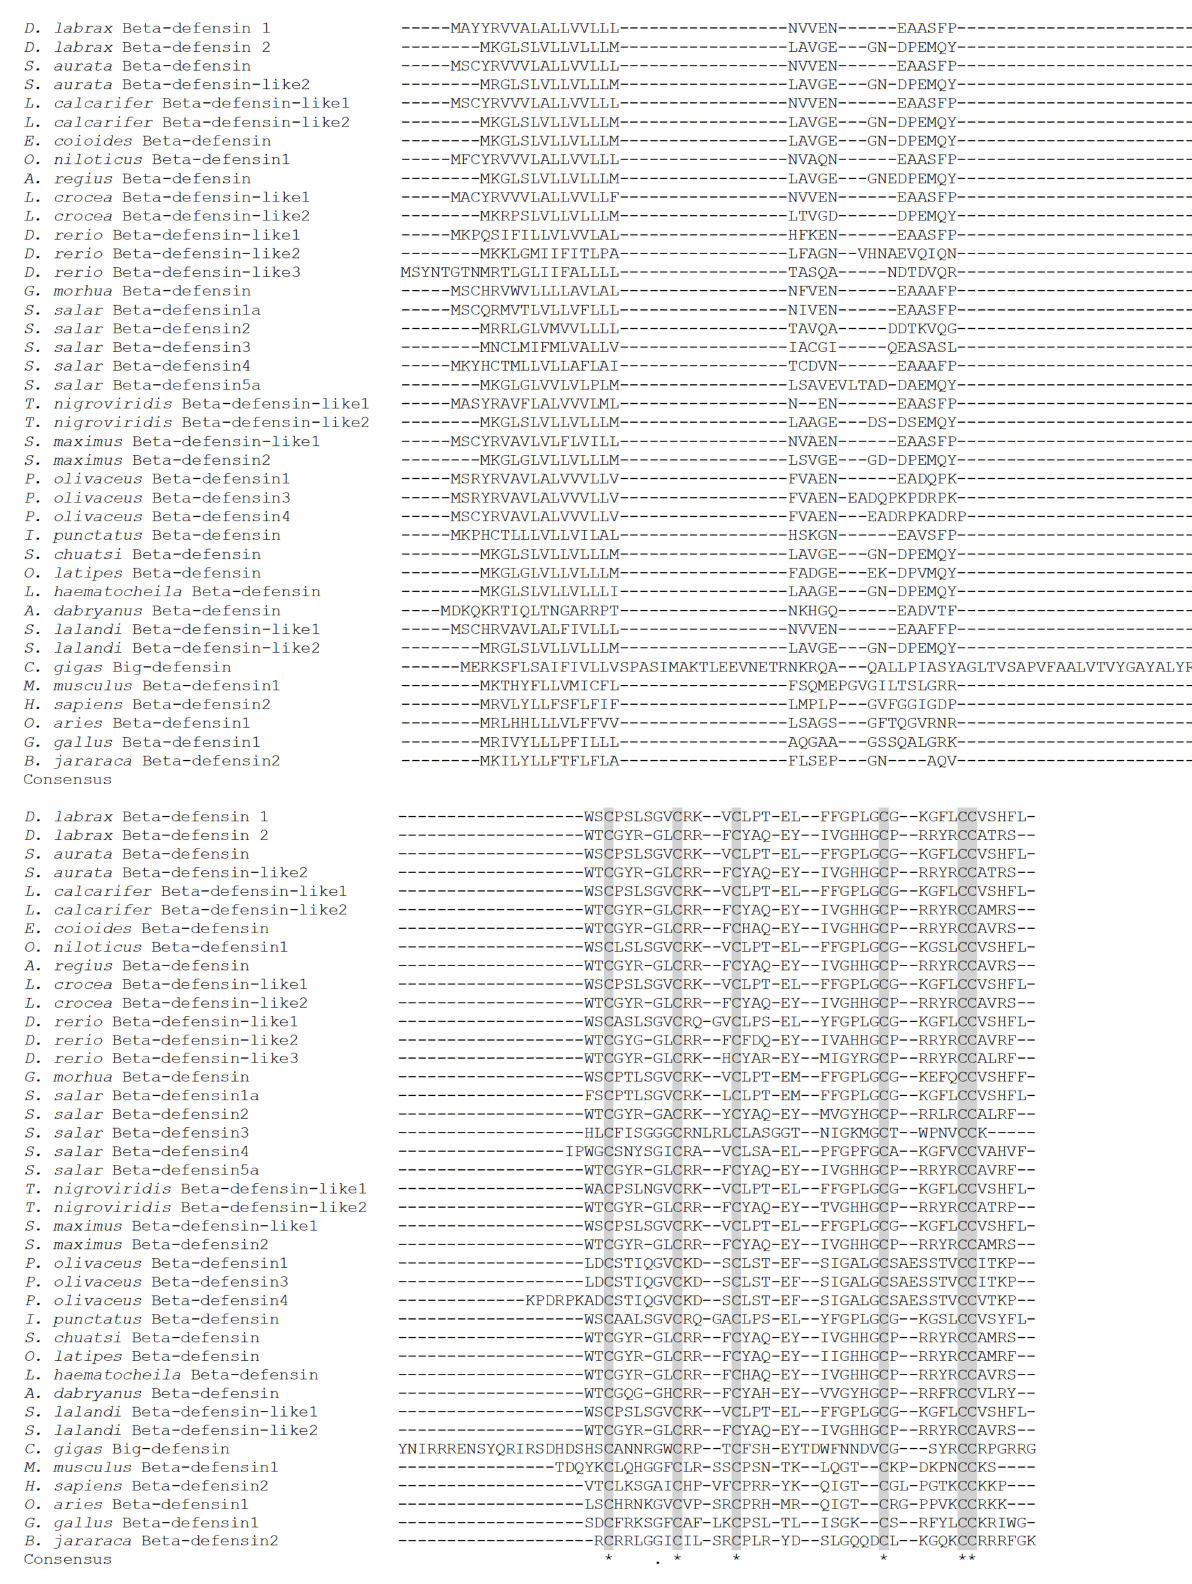
Figure 5. Alignment of sea bass beta-defensins with peptides from other vertebrate species. Cysteines are shaded gray and are denoted by (*) and semi-conserved substitutions by